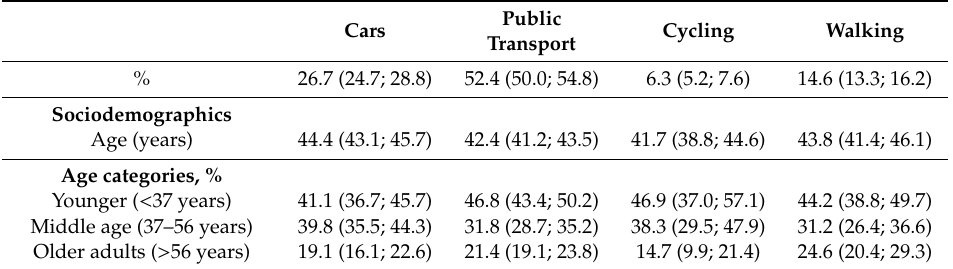
Table 1. Descriptive characteristics of participants by active travel